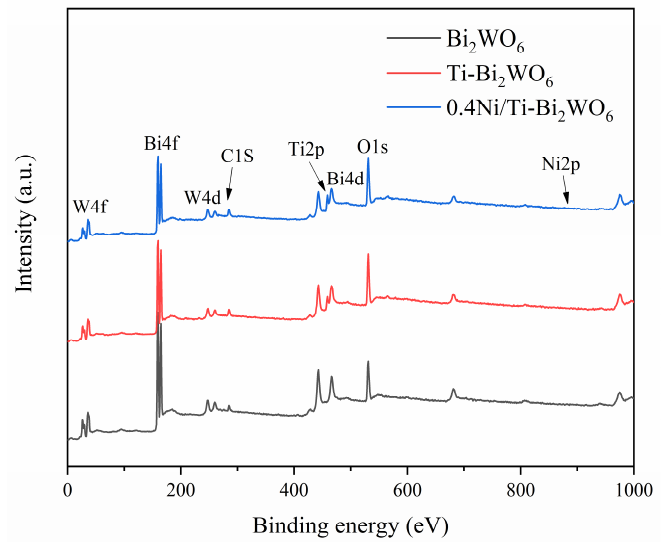
Figure 5. XPS survey spectrum of various samples.